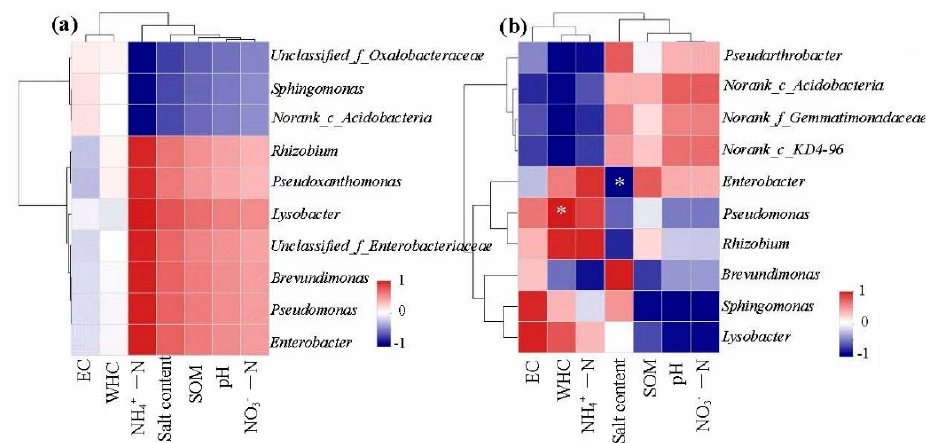
Figure 6. The Pearson correlation heatmap of soil properties and the relative abundance of bacterial community at genus level in the coastal soil without ( a ) and with ( b ) 1.5% WB. EC: Electrical conductivity; SOM: Soil organic matter; NH 4+ - N: Ammonium nitrogen; NO 3 − - N: Nitrate nitrogen. Red indicated a positive correlation and blue indicated a negative correlation. The darker the color, the greater the correlation. * Significant at 0.01 < p < 0.05.